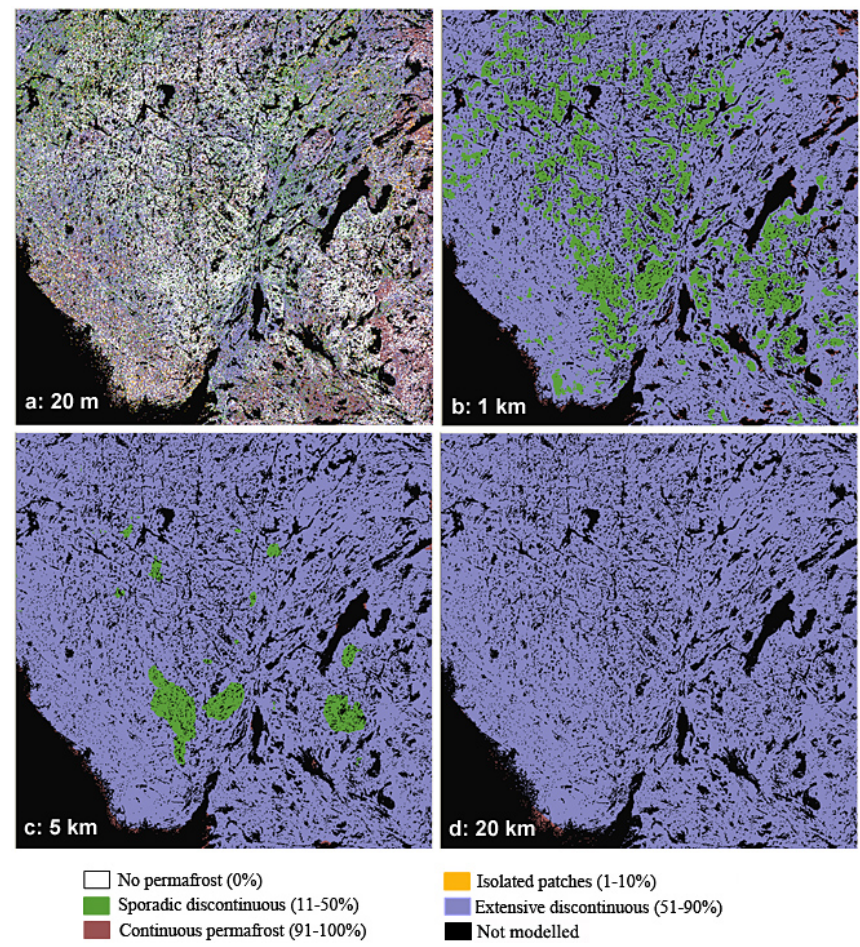
Figure 10. The effects of spatial resolution (shown in the panels) on permafrost zonal distributions. These maps were produced by dividing permafrost probability in the 2000s (Fig. 5b) into five zones and then re-sampled to different spatial